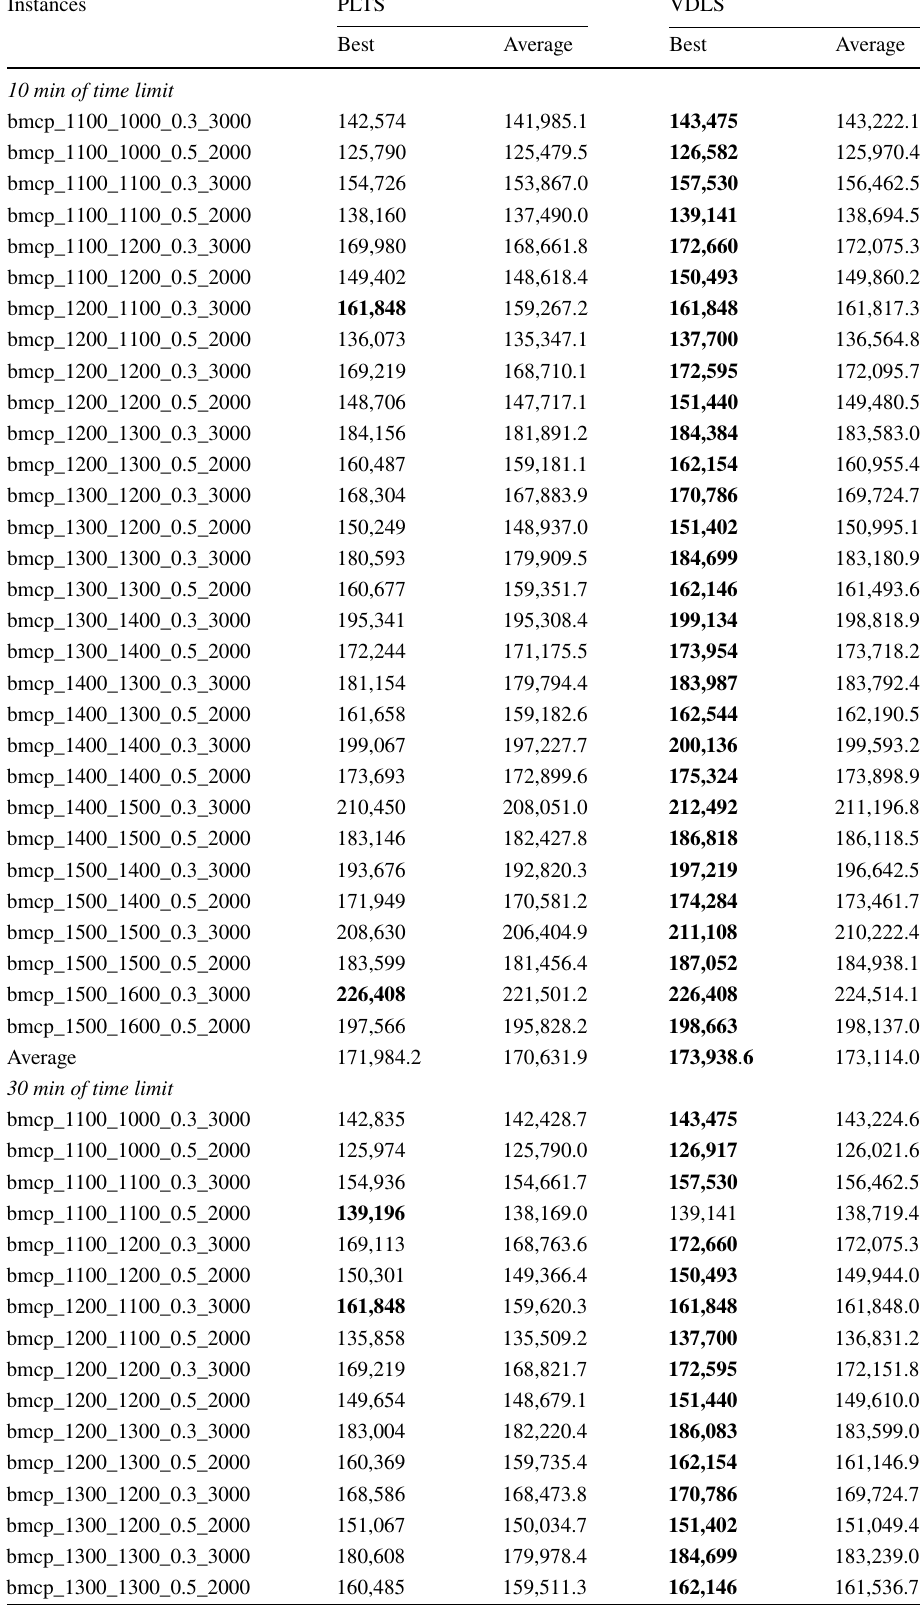
Table 4 Comparison results of VDLS and PLTS, with 10 or 30 min of time limit, on the 30 instances of the second